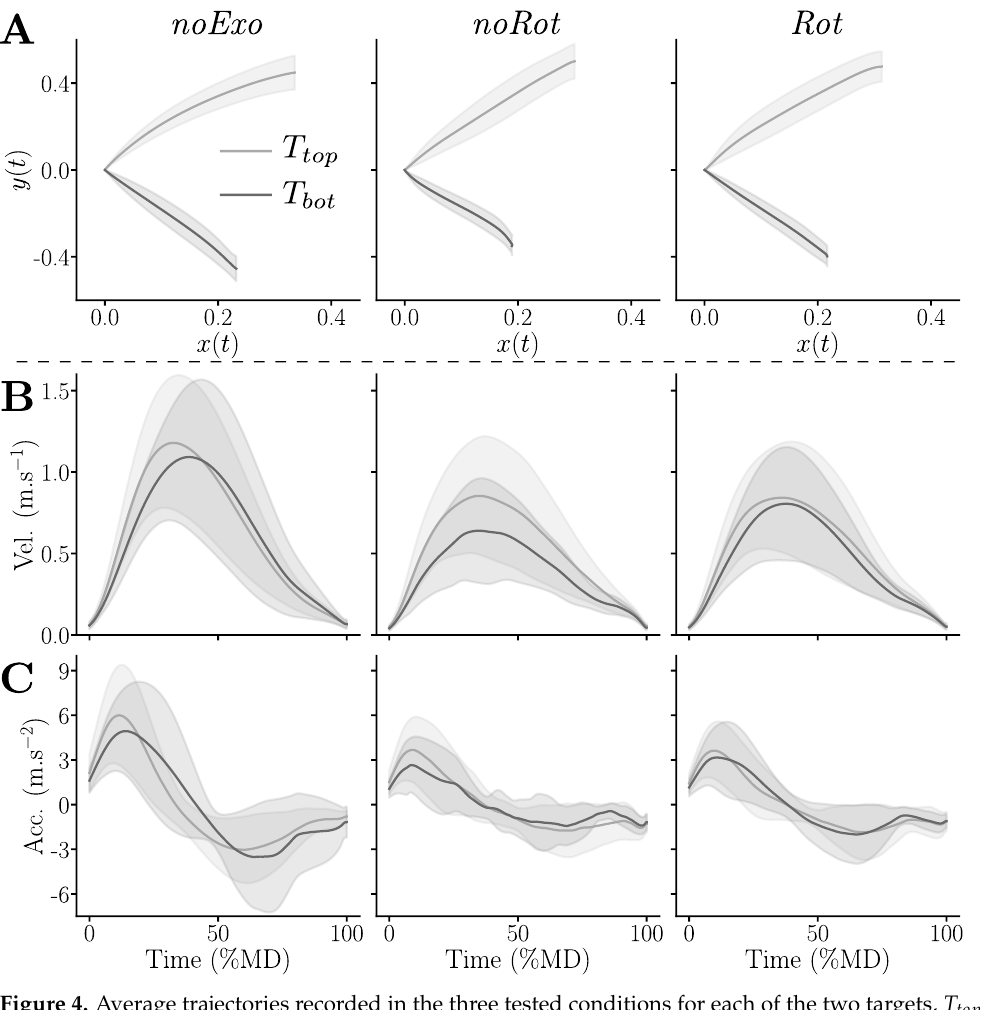
Figure 4. Average trajectories recorded in the three tested conditions for each of the two targets, T top and T bot . ( A ) Consecutive positions of the index in the sagittal plane ( x , y ) (see Figure 1B). ( B ) Velocity profiles normalized by MD. ( C ) Acceleration profiles normalized by